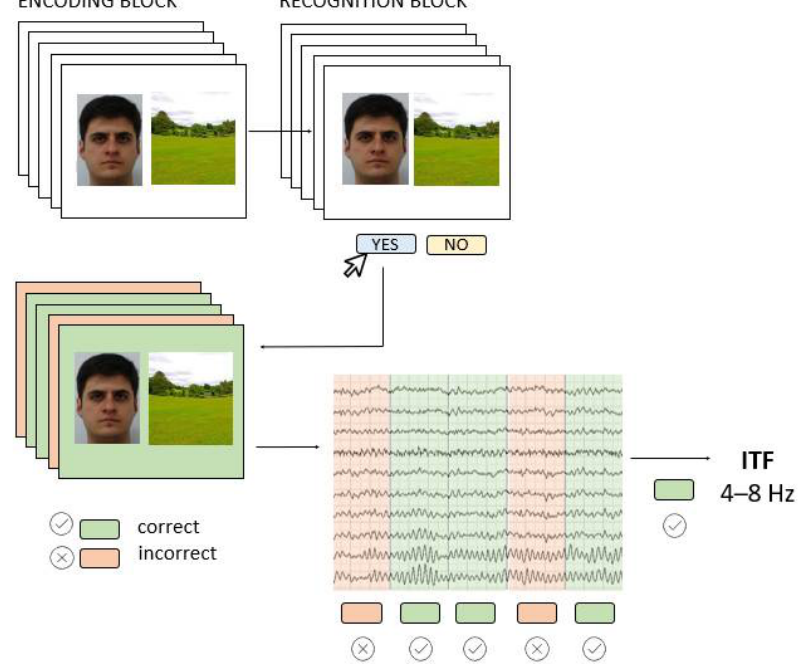
Figure 1. The AM task (Encoding and Recognition block) was performed while EEG was recorded; the EEG signals from the Encoding block were used to extract individual theta frequencies (ITF) for subsequently correctly recognized pairs.